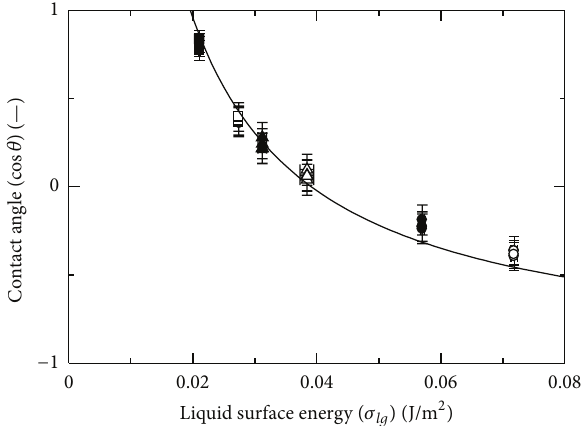
Figure 2: Relationship between the liquid surface energy and contact angle for different drop volumes from 5 𝜇 L to 40 𝜇 L.